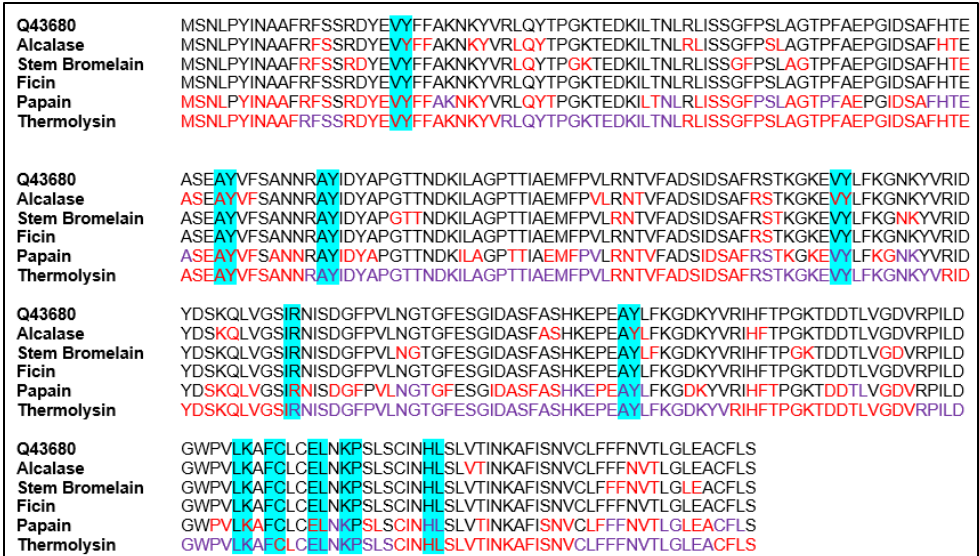
Figure 5. Locations of possible hydrolysis, by proteases selected, within the mung bean albumin sequence Q43680 of the UniProt Database. Amino acids in the sequence are coded using their one letter abbreviation. Hydrolysis is expected to occur between any two adjacent amino acids color-coded the same color (red or purple), but not between amino acids color-coded with different colors or in black text. Each block represents a part of the sequence depicting the different specificities of the proteases stated in the left column. The top block is the start of the sequence. Antioxidant fragments according to the BIOPEP Database in the sequence are highlighted in blue.